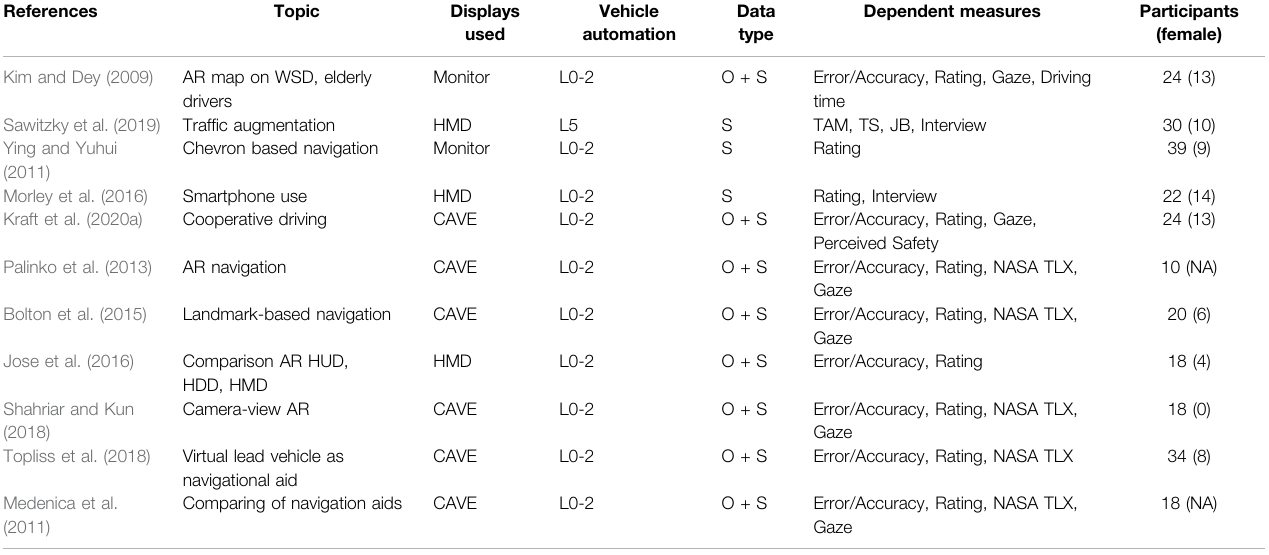
TABLE 3 | Summary of user studies in Vehicle Navigation and Routing application area.